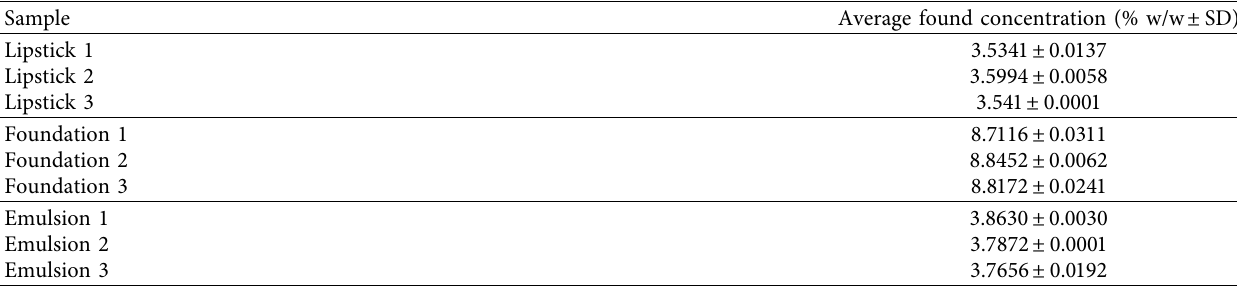
Table 3: ZnO content in samples of lipstick, foundation, and emulsion products. Sample